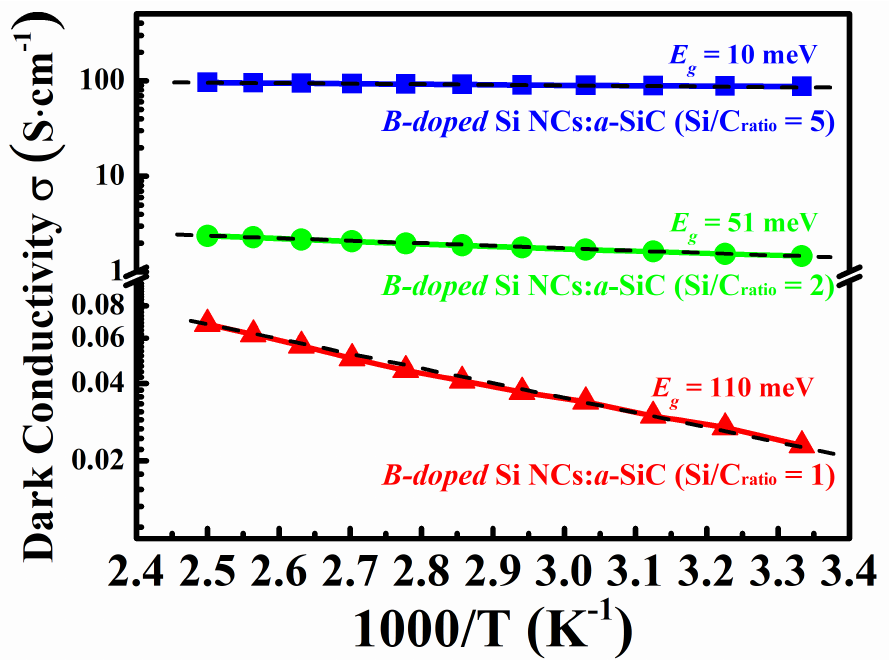
Figure 4. Temperature-dependent conductivities of B-doped Si NCs: a -SiC films above room temperature. The temperature-dependent conductivities of B-doped Si NCs: a -SiC films with R = 1 and 5 were also measured below room temperature (10 K~300 K). It can be found that